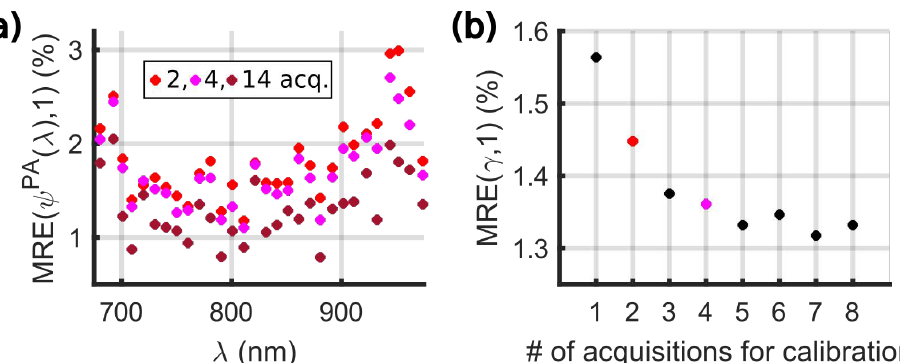
Figure 5. Evaluation of the influence of the number of acquisitions taken to compute the median of A PA calibration ( λ ). ( a ) Median relative error (MRE) of Ψ PA vs. the optical wavelength λ for combinations of 2, 4, and 14 acquisitions out of 14 to evaluate the median of A PA calibration ( λ ) per tube. ( b ) MRE for the fitting factor for combinations from 1 to 8 acquisitions out of 14 to evaluate the median of A PA calibration ( λ ) per